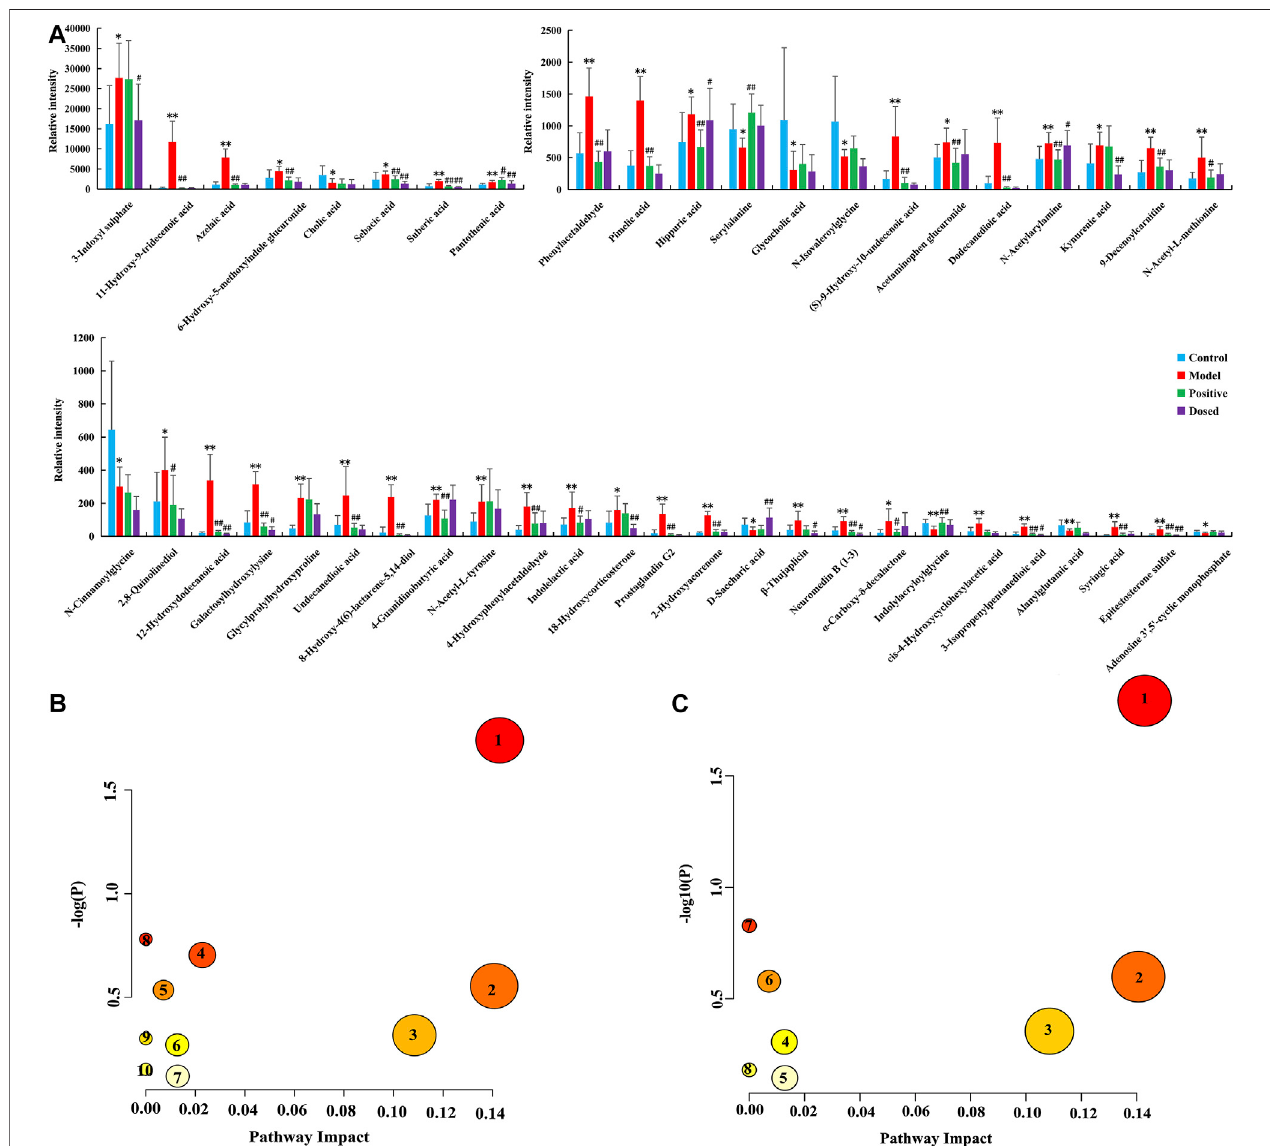
FIGURE3| Systemsanalysisofthemetabolomicalterationsineachgroup. (A) Histogramoftherelativeexpressionlevelsofthebiomarkers, (B) Metabolicpathway analysis associated with the pathogenesis of PD by MetaboAnalyst 5.0 (1. phenylalanine metabolism, 2. pentose and glucuronate interconversions, 3. arachidonic acid metabolism,4.primarybileacidbiosynthesis,5.pantothenateandCoAbiosynthesis,6.tyrosinemetabolism,7.steroidhormonebiosynthesis,8.ascorbateandaldarate metabolism,9.arginineandprolinemetabolism,and10.purinemetabolism), (C) Metabolicpathwayanalysisassociatedwiththeef fi cacyofDSSbyMetaboAnalyst 5.0 (1. phenylalanine metabolism, 2. pentose and glucuronate interconversions, 3. arachidonic acid metabolism, 4. tyrosine metabolism, 5. steroid hormone biosynthesis, 6. pantothenate and CoA biosynthesis, 7. ascorbate and aldarate metabolism, and 8. purine metabolism).